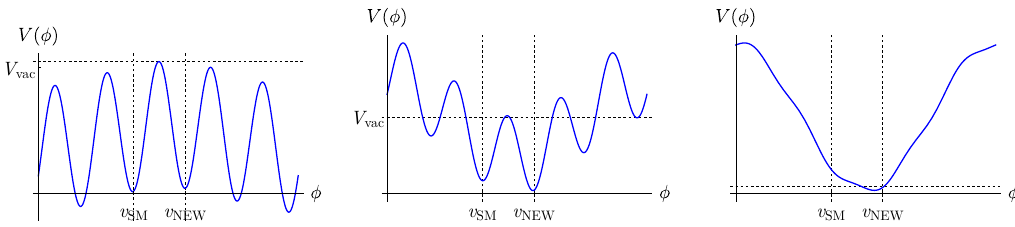
Figure 1 . A schematic picture of the form of a scalar potential in environments with di(cid:11)erent standard model densities that allow a con(cid:12)ned bubble. (Left) At zero density, the standard model minimum v SM and a di(cid:11)erent minimum v NEW are nearly degenerate. (Middle) At intermediate density below the critical density, the standard model minimum v SM gets lifted by scalar interactions with matter, and regions with (cid:30) = v NEW can expand. (Right) At high enough density, the barrier disappears and the standard model minimum is no longer a minimum of the theory, and regions with (cid:30) = v NEW can be classically generated. The horizontal dashed line shows the size of the barrier of the potential in empty space. In terms of the toy model in 2.1, the full (cid:12)eld range shown in